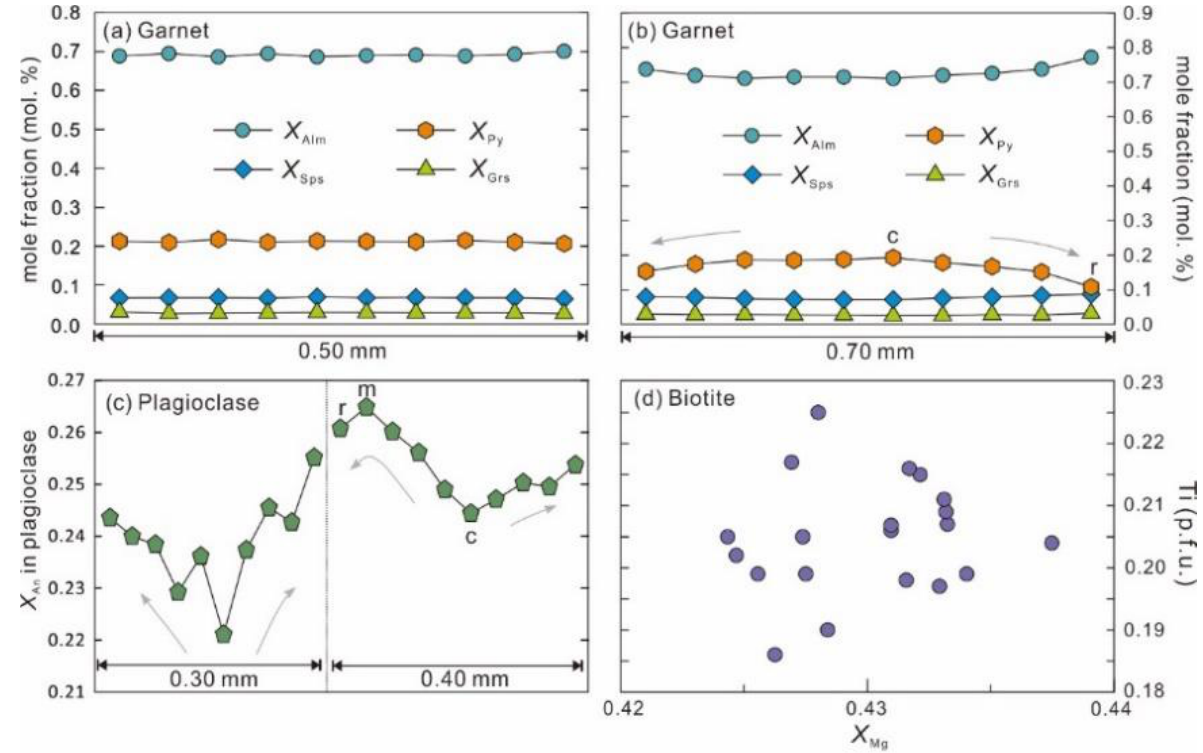
Figure 3. ( a , b ) Composition zoning profiles for garnets. ( c ) X An profiles of plagioclases. ( d ) X Mg Figure 3. ( a,b ) Composition zoning profiles for garnets. ( c ) X versus Ti diagram showing the compositions of biotite. X Alm [=Fe 2+ /(Fe 2+ +Mg+Ca+Mn)], defined versus Ti diagram showing the compositions of biotite. X accordingly for X Py , X Grs and X Sps ; X An = Ca/(Ca+Na+K); X Mg = Mg/(Mg+Fe 2+ accordingly for X , X and X ; X = Ca/(Ca+Na+K); X Py Grs Sps An